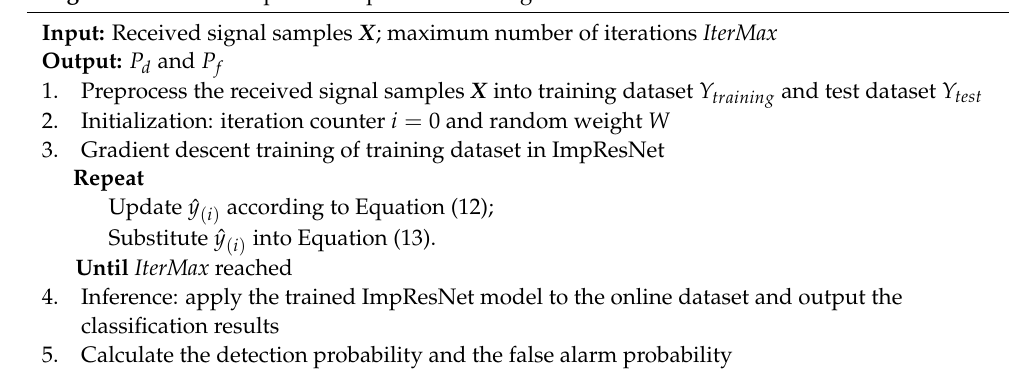
Algorithm 1: STFT-ImpResNet Spectrum Sensing